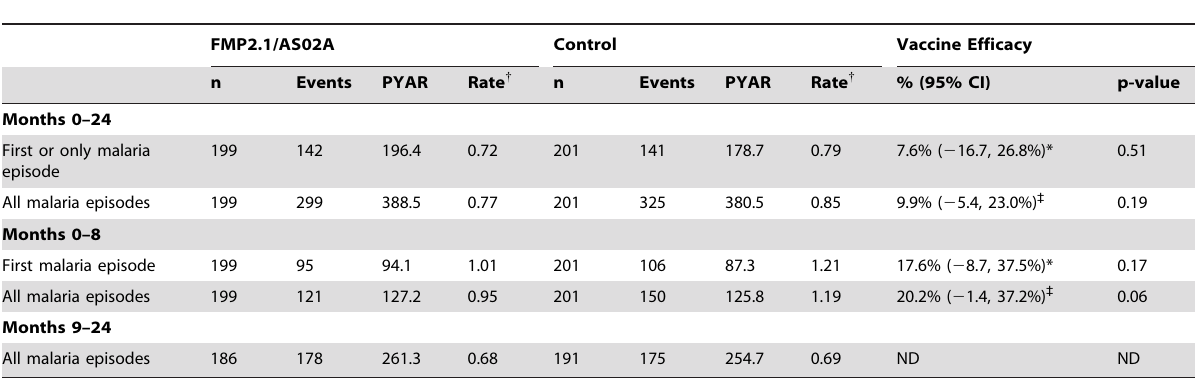
Table 3. Vaccine efficacy against P. falciparum malaria, intention-to-treat cohort.